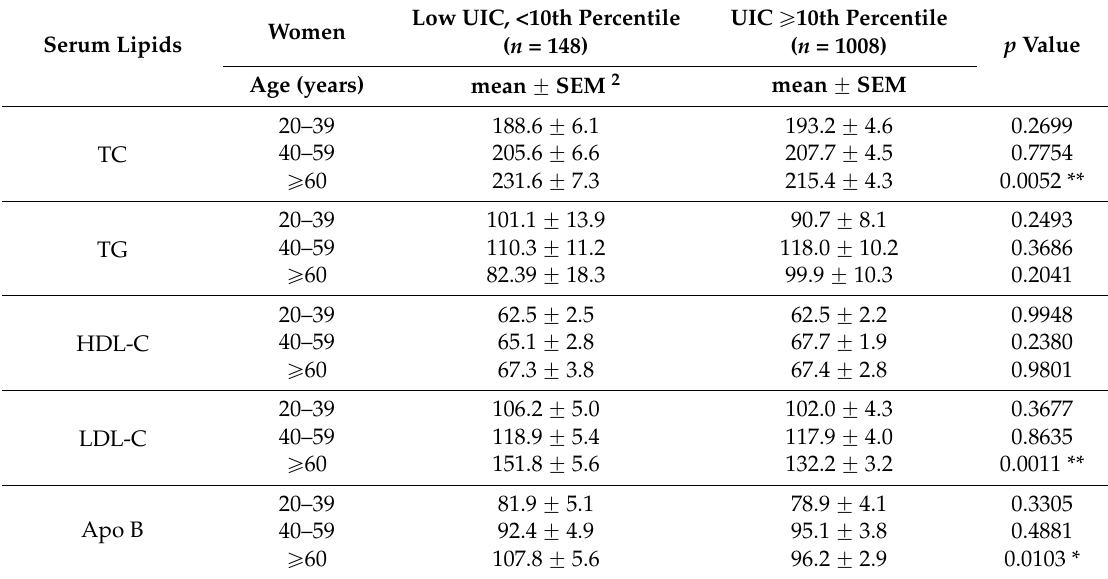
Table 3. Serum lipid profiles by urinary iodine concentration in US women, NHANES 2007–2012 1 .